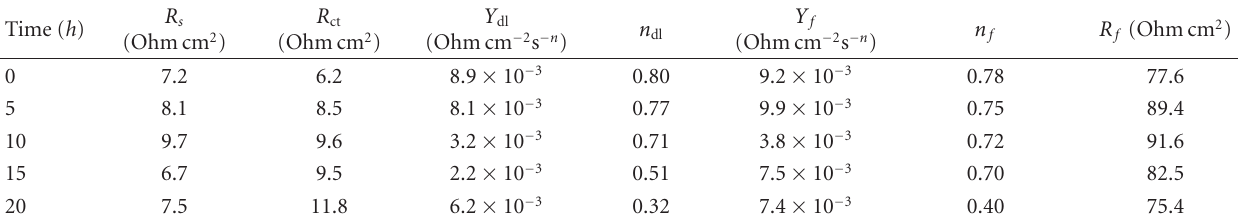
Table 2: Parameters used to simulate the EIS data for Fe-40Al-2.5Ag alloy.